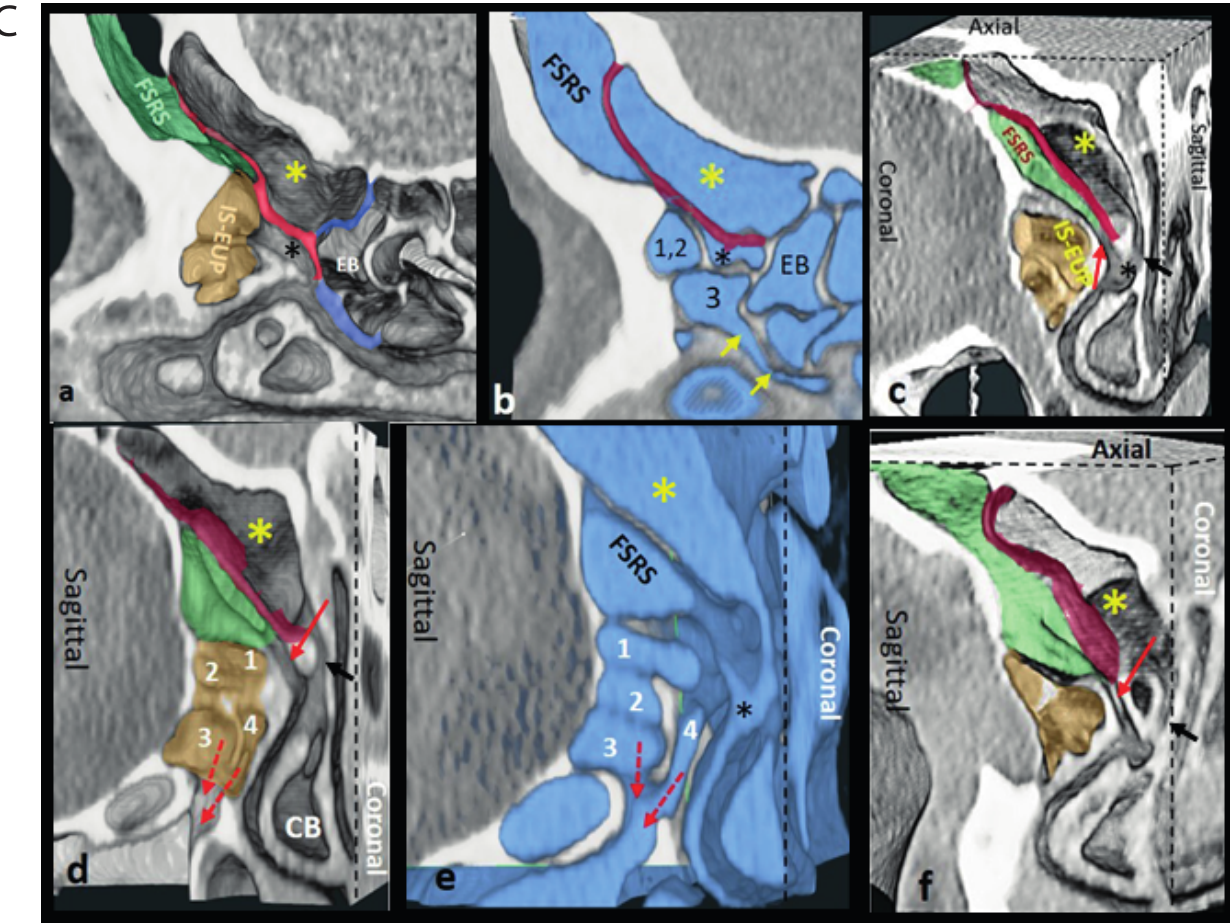
Figure 6. C. The “contracted/diminished” Frontal Recess altered by a Common Lamella. a.-f. 3D sagittal images (Figs. a and b), and various obliquely viewed coronal 3D images (Figs. c.-f) show the prominent reduction in the size of the FSRS (green outline) as a result of the anteriorly extended common lamella (red outline), creating an interlamellar space (yellow asterisk) bordered posteriorly by the bulla lamella (blue outline), resulting in a pronounced narrowing of the FSRS (green outline, FSRS). Figs. b. and e. represent 3D images showing the air spaces (blue outline) and correspond with figs. a. and d., respectively. The FSRS (green outline) drains directly into the EI (red arrow). The ILS (yellow asterisk) drains into the Middle Meatus (black arrow). IS-EUP (gold outline, spaces 1-4) drains into the TI (dashed red arrows, solid yellow arrows). CB: Concha